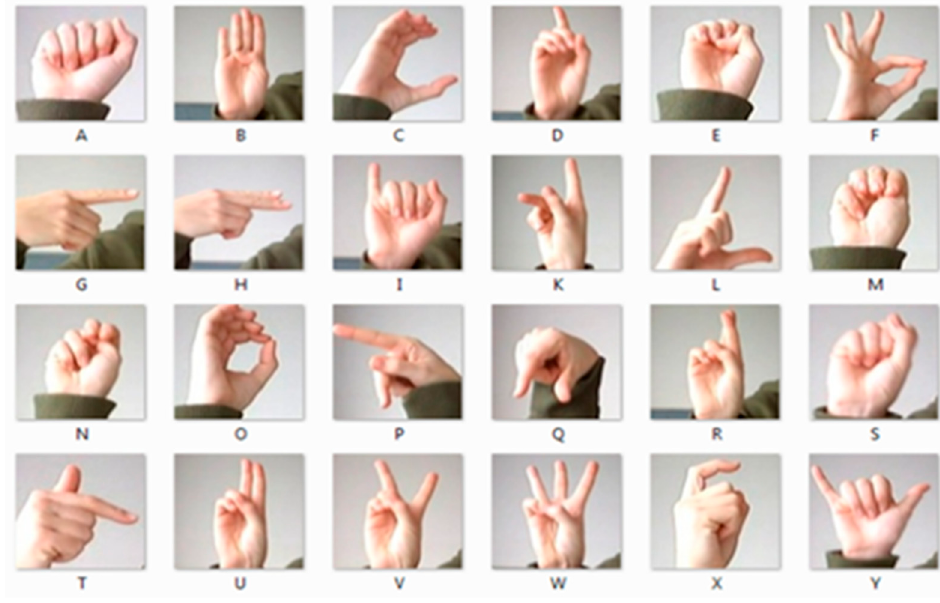
Figure 1. Sign language dataset [31].